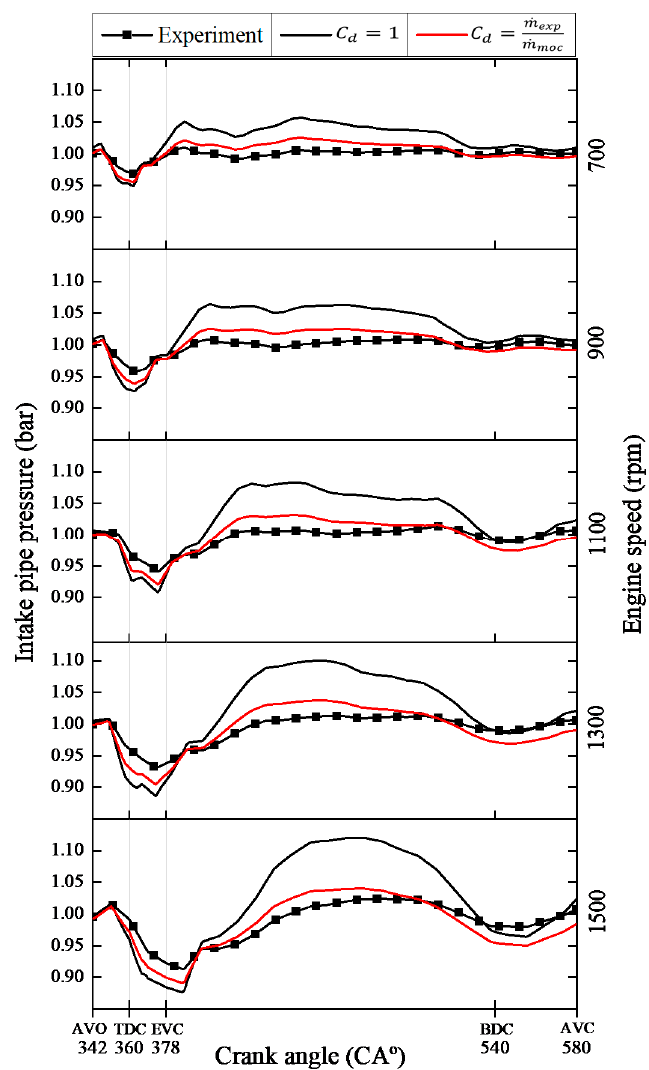
Figure 7. Comparison of the experiment and 1D gas flow analysis results of the intake pipe pressure during the intake period.